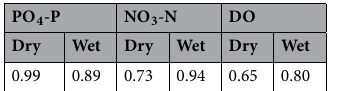
Table 4. Nash Sutcliffe coefficient results for the water quality